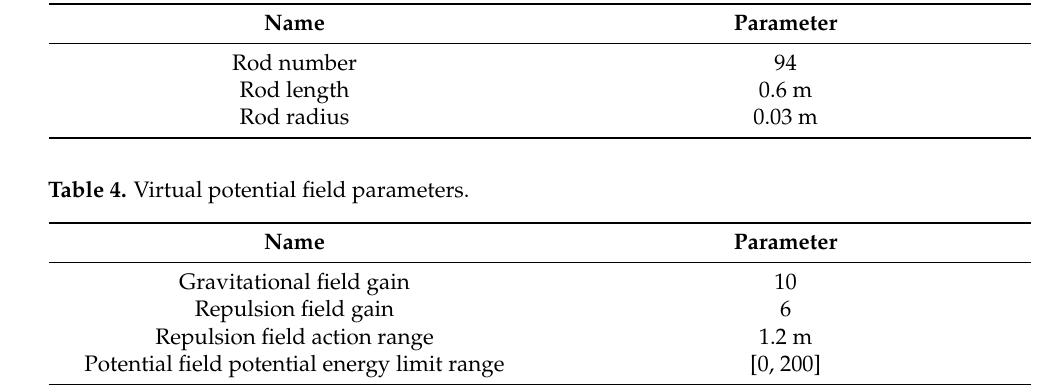
Table 3. Truss model parameters.